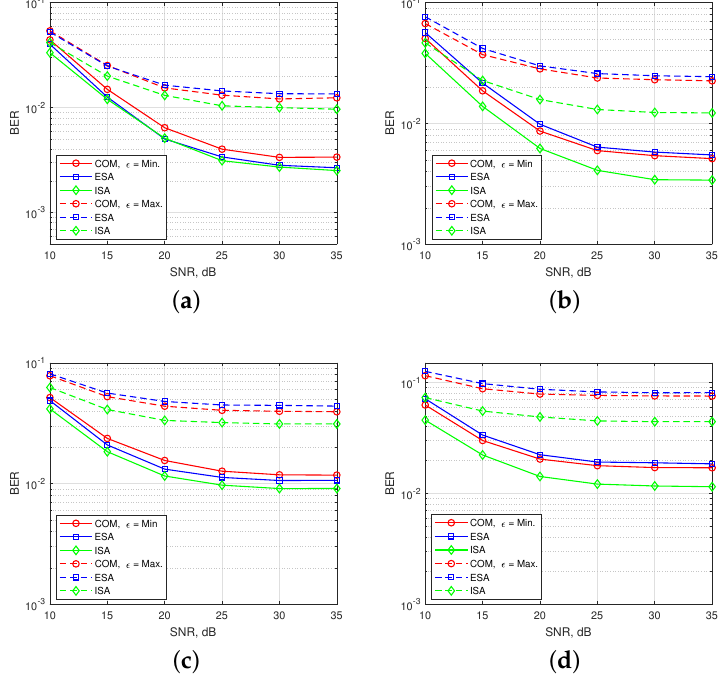
Figure 10. BER performance of multi-user OFDM-IM regarding to three SMS-s. Only time offset between the machine users is considered for ( a ) and ( b ), while both time and power offset are considered for ( c ) and ( d ). ( a ) SMS-s with s = 8 and v = 3. ( b ) SMS-s with s = 8 and v = 4. ( c ) SMS-s with s = 8 and v = 3. ( d ) SMS-s with s = 8 and v =